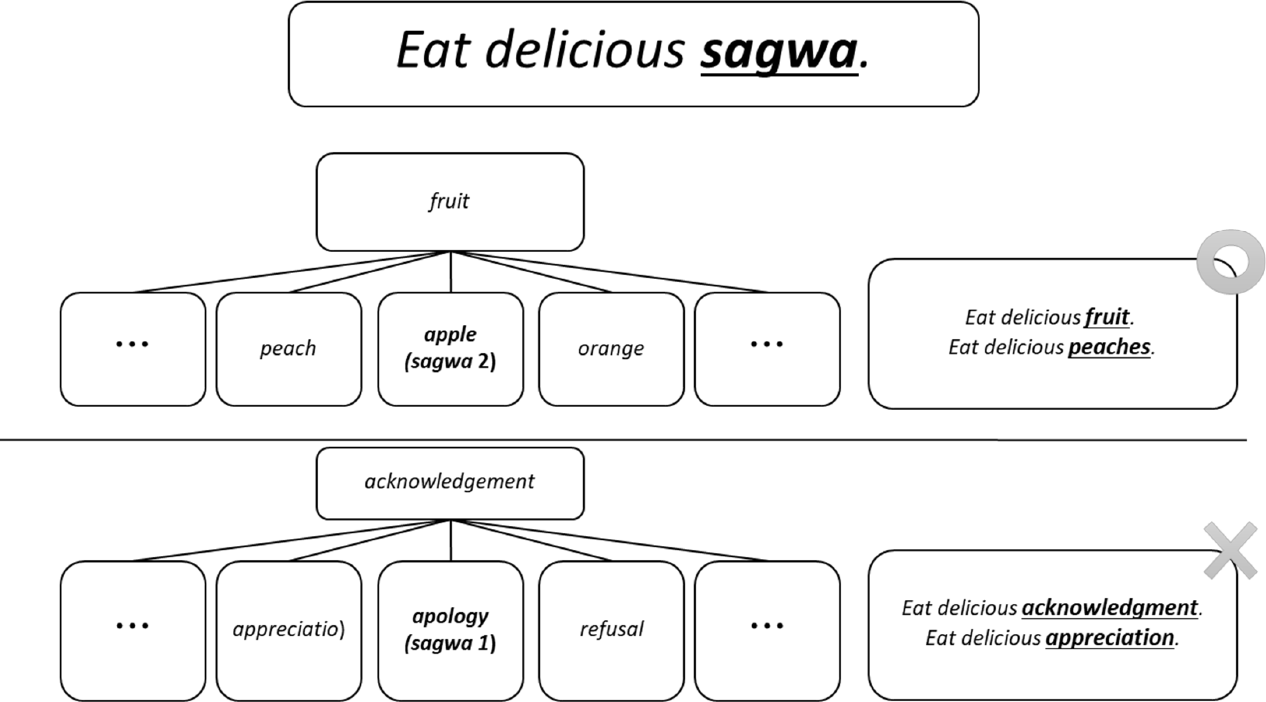
Figure 2. Coordinate terms of sagwa and relationship between words appearing in the local context.